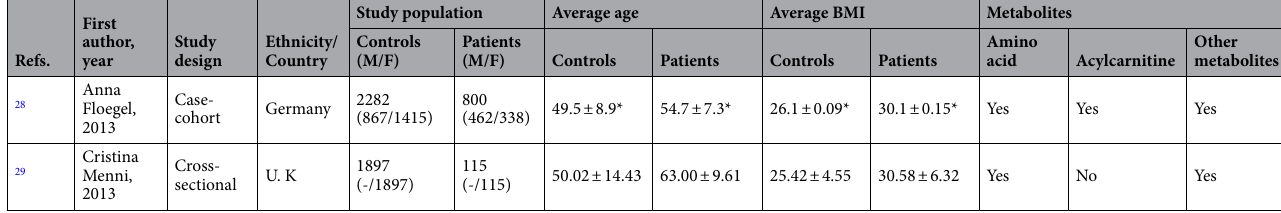
Table 4. Literature review on biomarkers in diabetes metabolomics studies. **Data reported as median (IQR); *Data reported as mean ± SEM; others reported as mean ± SD. M: Male; F: Female; BMI: Body mass